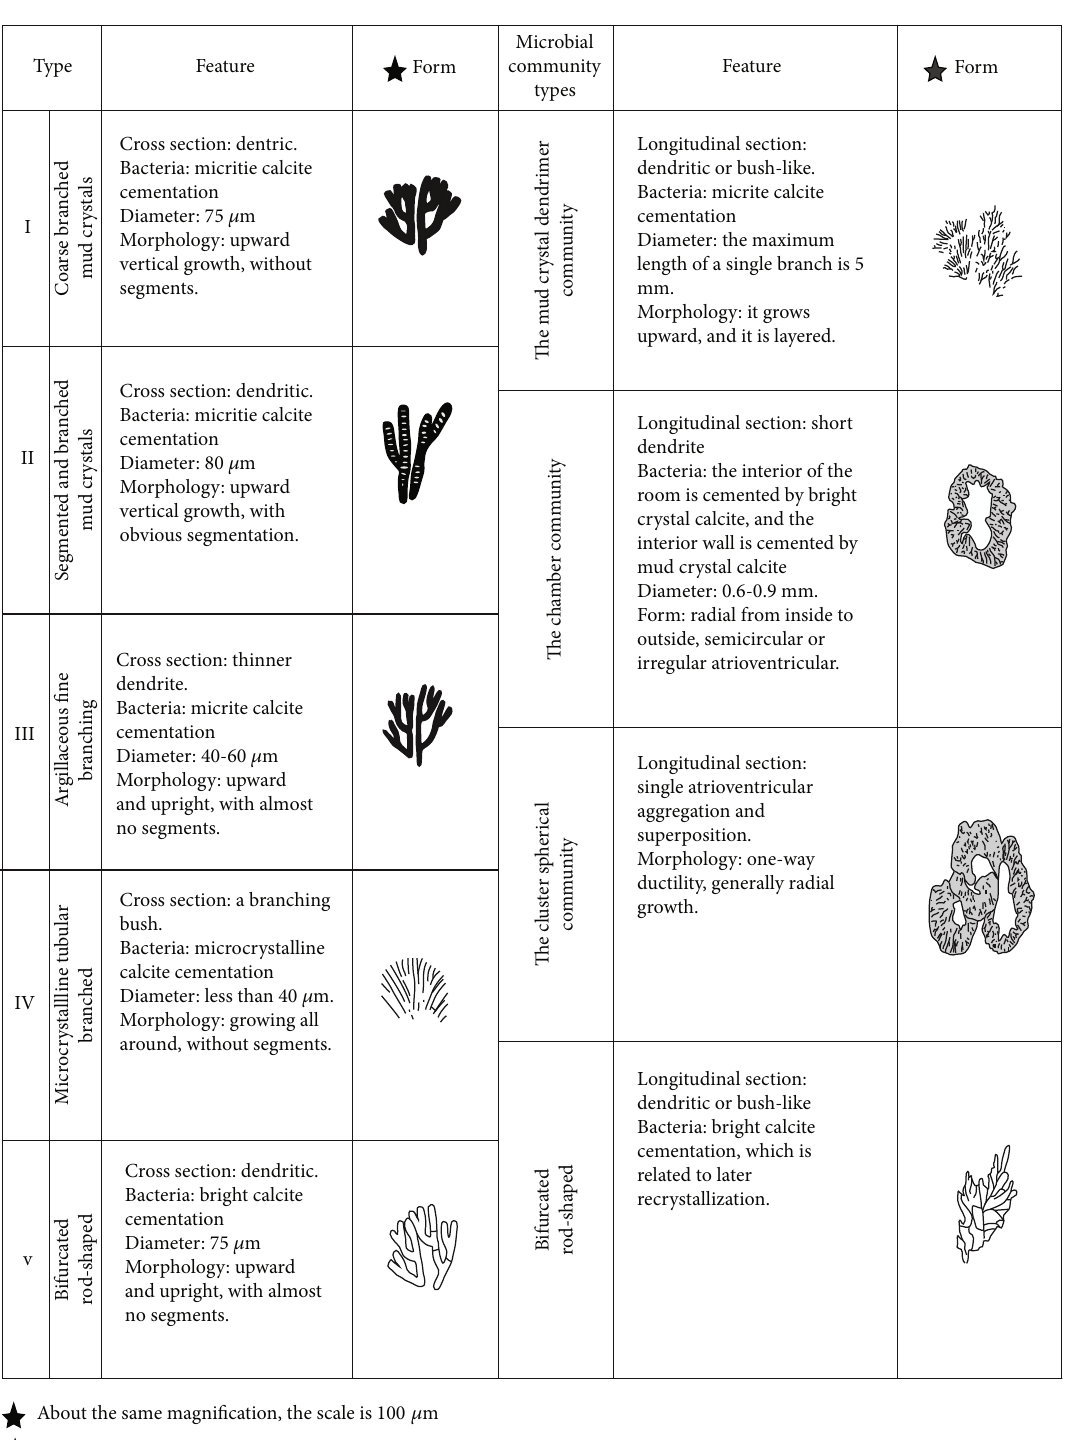
Figure 5: Morphologic types of Epiphyton and Epiphyton thalli of dendrolite of Cambrian in Western Shandong Province (revised according to [21,